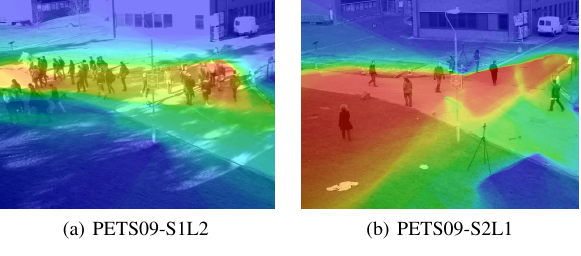
Figure 3. Prior knowledge about the